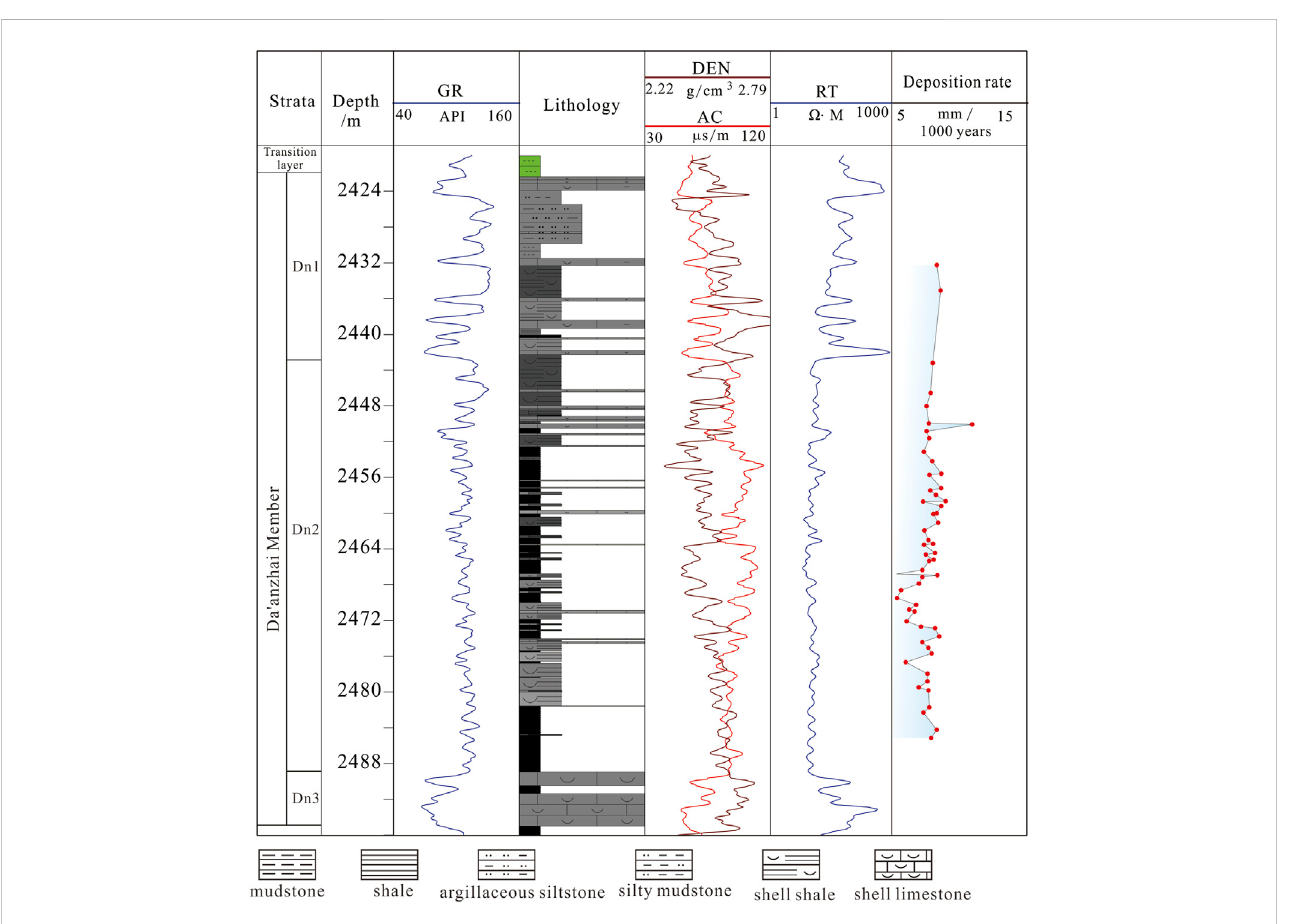
FIGURE 10 Vertical variation of sedimentation rates in Da ’ anzhai Member of Well RA1. GR, Natural gamma ray logging; AC, Acoustic logging; Rt, True formation resistivity logging, Dn1 – Dn3: sub-member of Da ’ anzhai